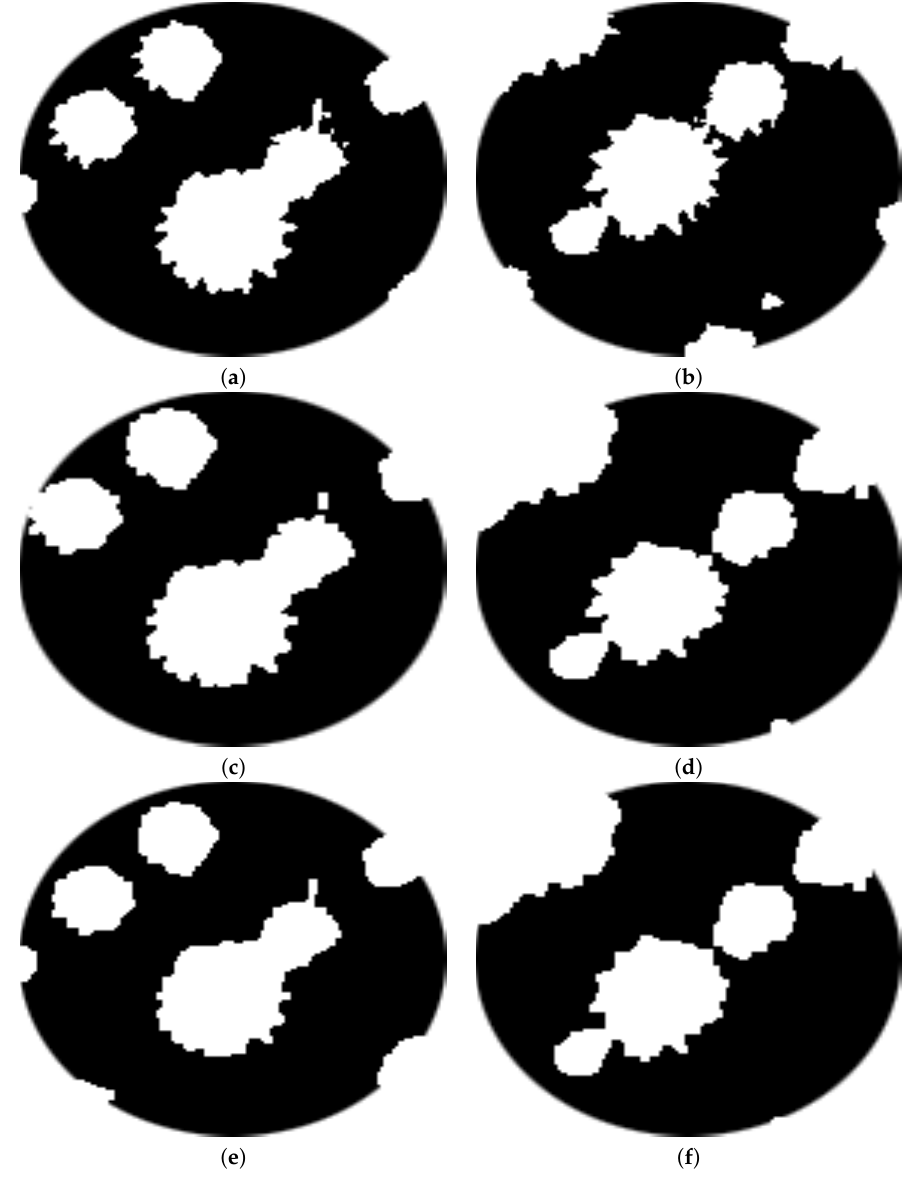
Figure 11. Morphological opening and closing: ( a ) zoom in on the circle in red on the left of Figure 10, ( c ) opening and ( e ) closing of the region in ( a ), ( b ) zoom in on the circle in red on the right of Figure 10, and ( d ) opening and ( f ) closing of the region in ( b